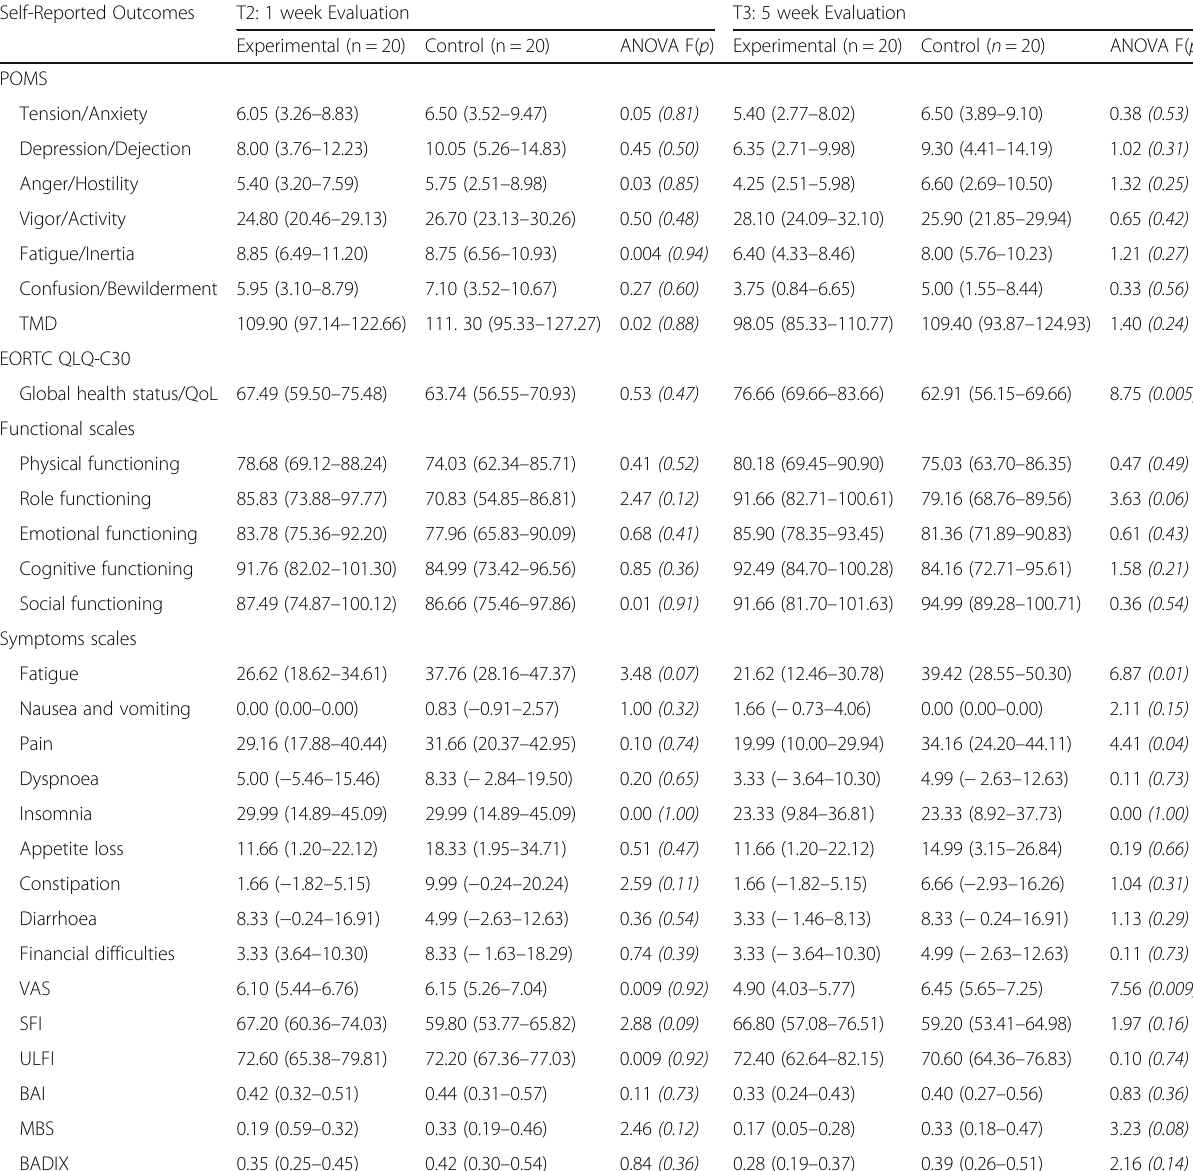
Table 3 Mean (CI 95%) and analysis of variance (ANOVA) of baseline. 1 and 5 week Patient-Reported Outcomes Self-Reported